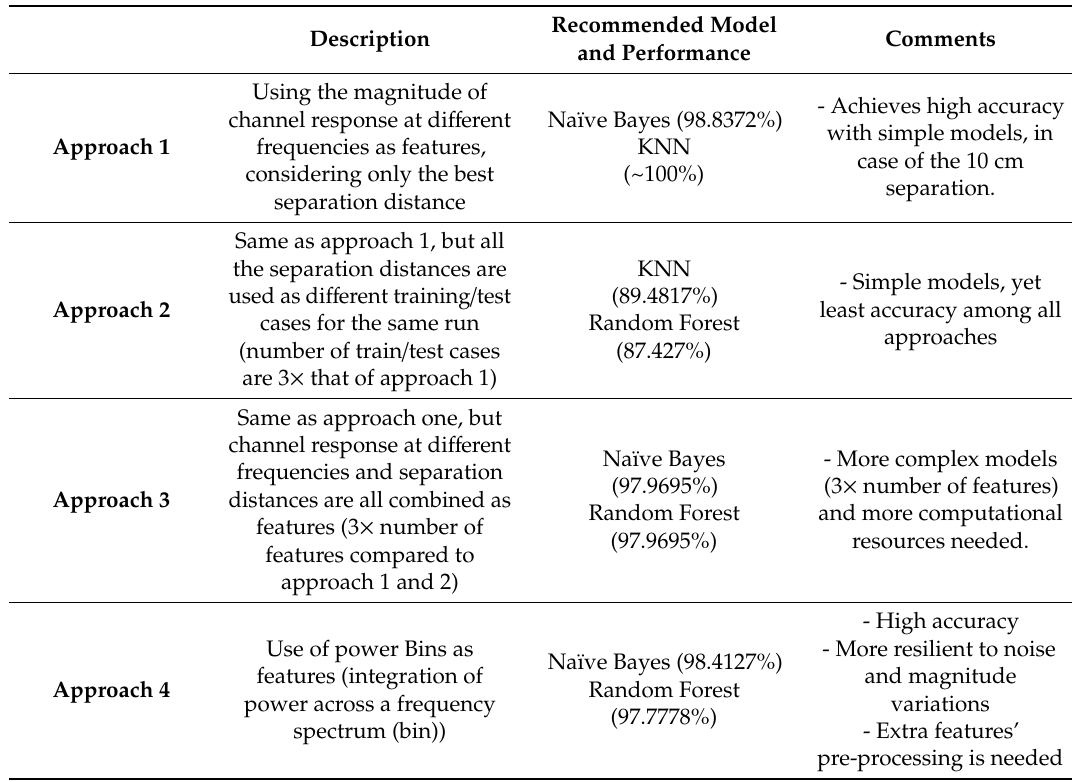
Table 7. Summary for the di ff erent features selection approaches and best performance result for